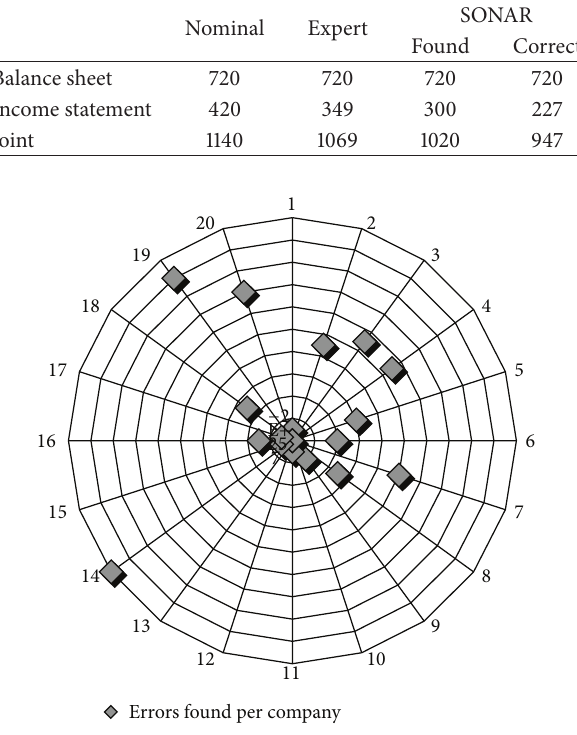
Figure 11: Error frequencies in companies in